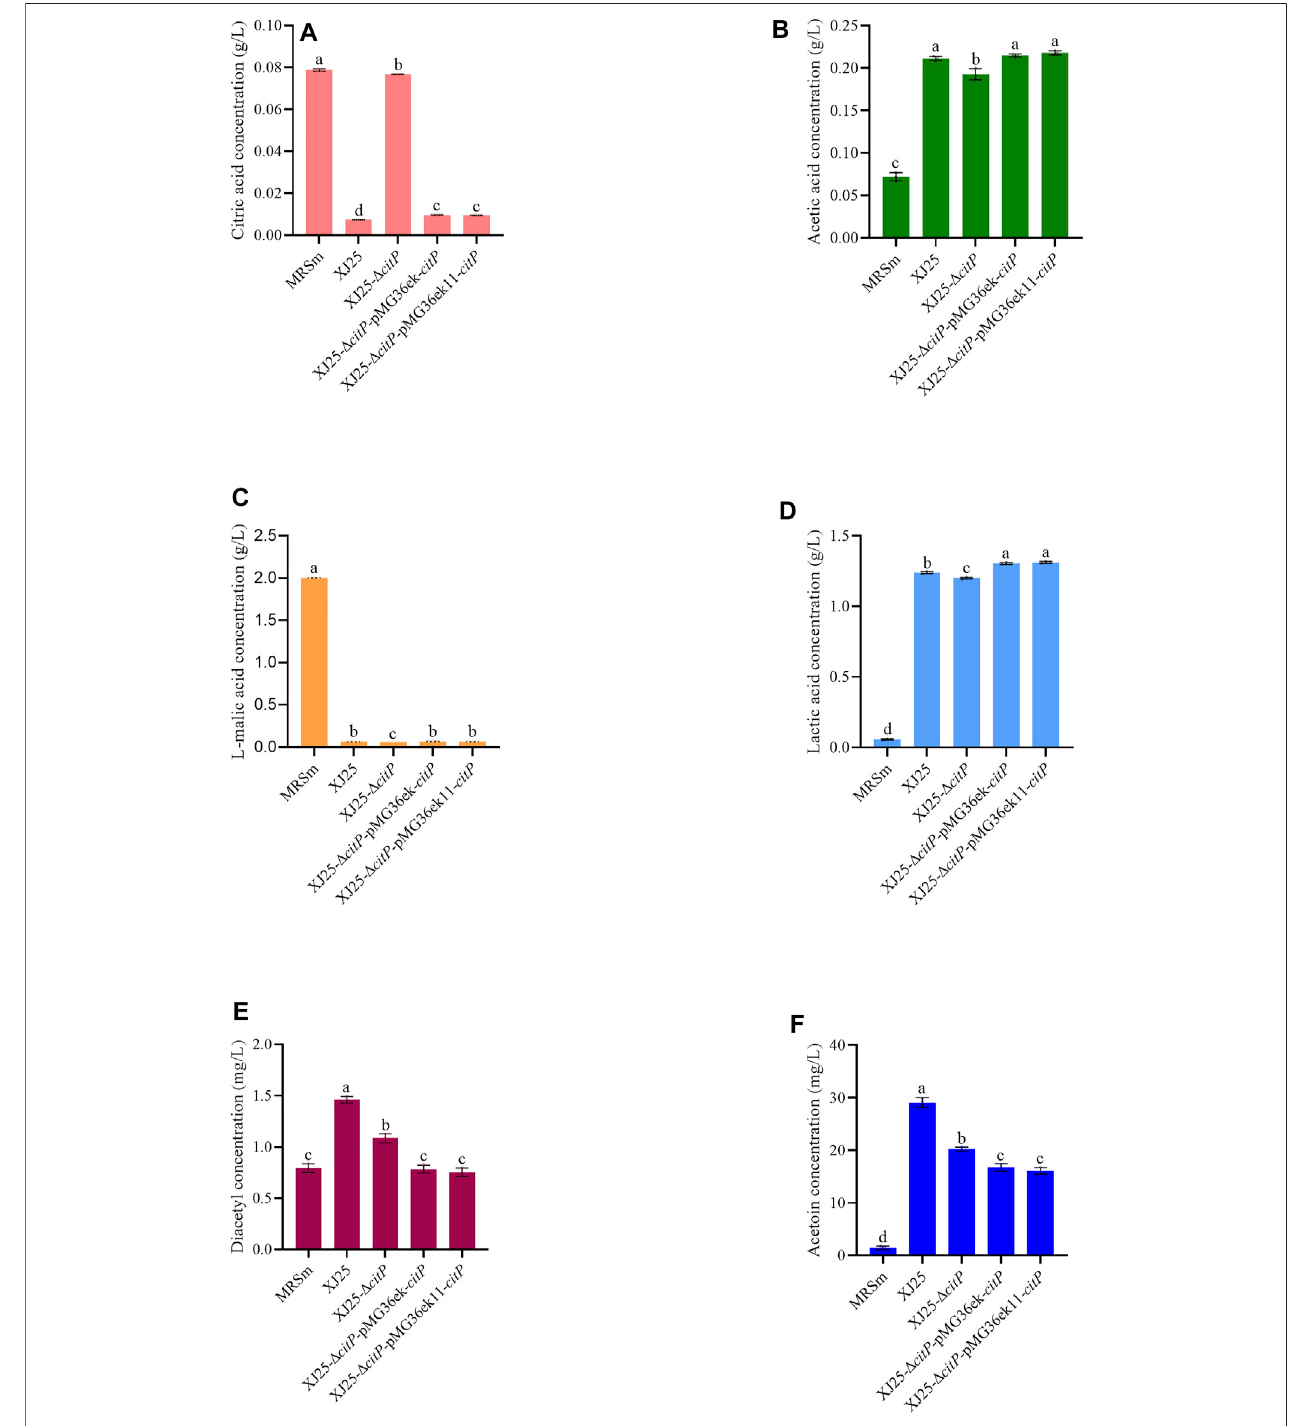
FIGURE 4 | Changes in metabolite concentration in the MRSm medium after 24 h culture with the wild-type and the mutants (A) citric acid, (B) acetic acid, (C) L-malicacid, (D) lacticacid, (E) diacetyland (F) acetoin.Dataareexpressedasmean±standarddeviation( n =3).a-emeanswithdifferentlower-caselettersinthesame row indicate signi fi cant differences ( p <